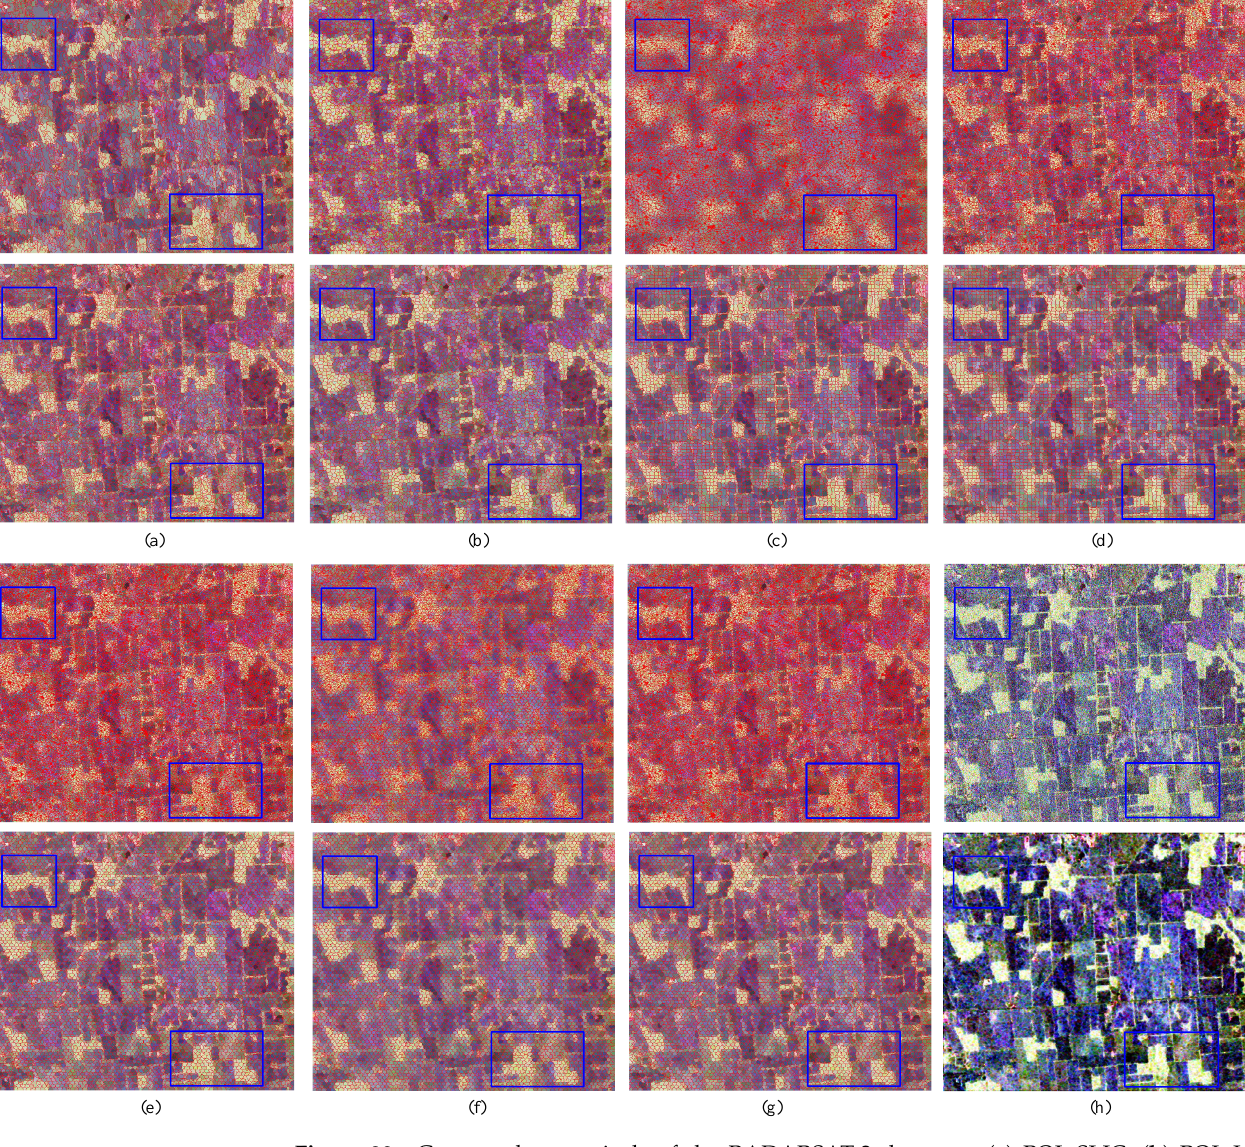
Figure 20. Generated superpixels of the RADARSAT-2 data set. ( a ) POL-SLIC. ( b ) POL-LSC. ( c ) POL-HLT. ( d ) WS. ( e ) HAWS. ( f ) HAGS. ( g ) The proposed HCI. ( h ) Pauli-RGB